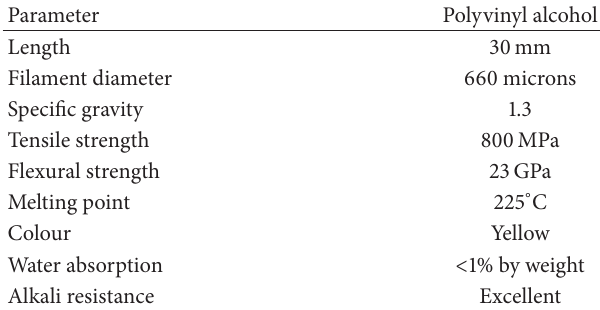
Table 3: Physical properties of polyvinyl alcohol fibers.